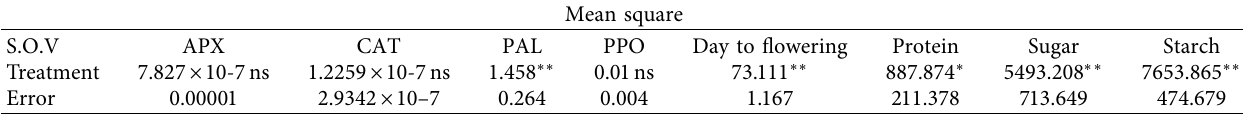
Table 1: Variance analysis for the effect of SA and pre-cold treatment on day to flowering and enzymatic traits of saffron. Mean square